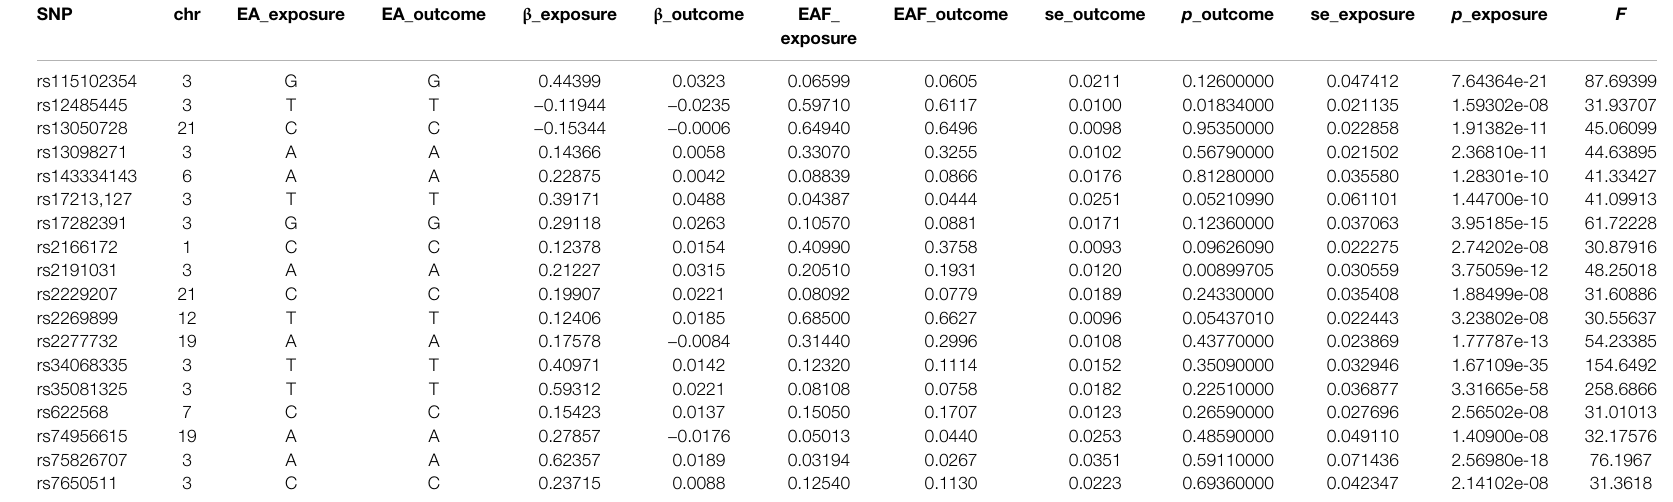
TABLE 2 | The single nucleotide polymorphism selected for hospitalized due to COVID-19 to perform Mendelian randomization analysis.